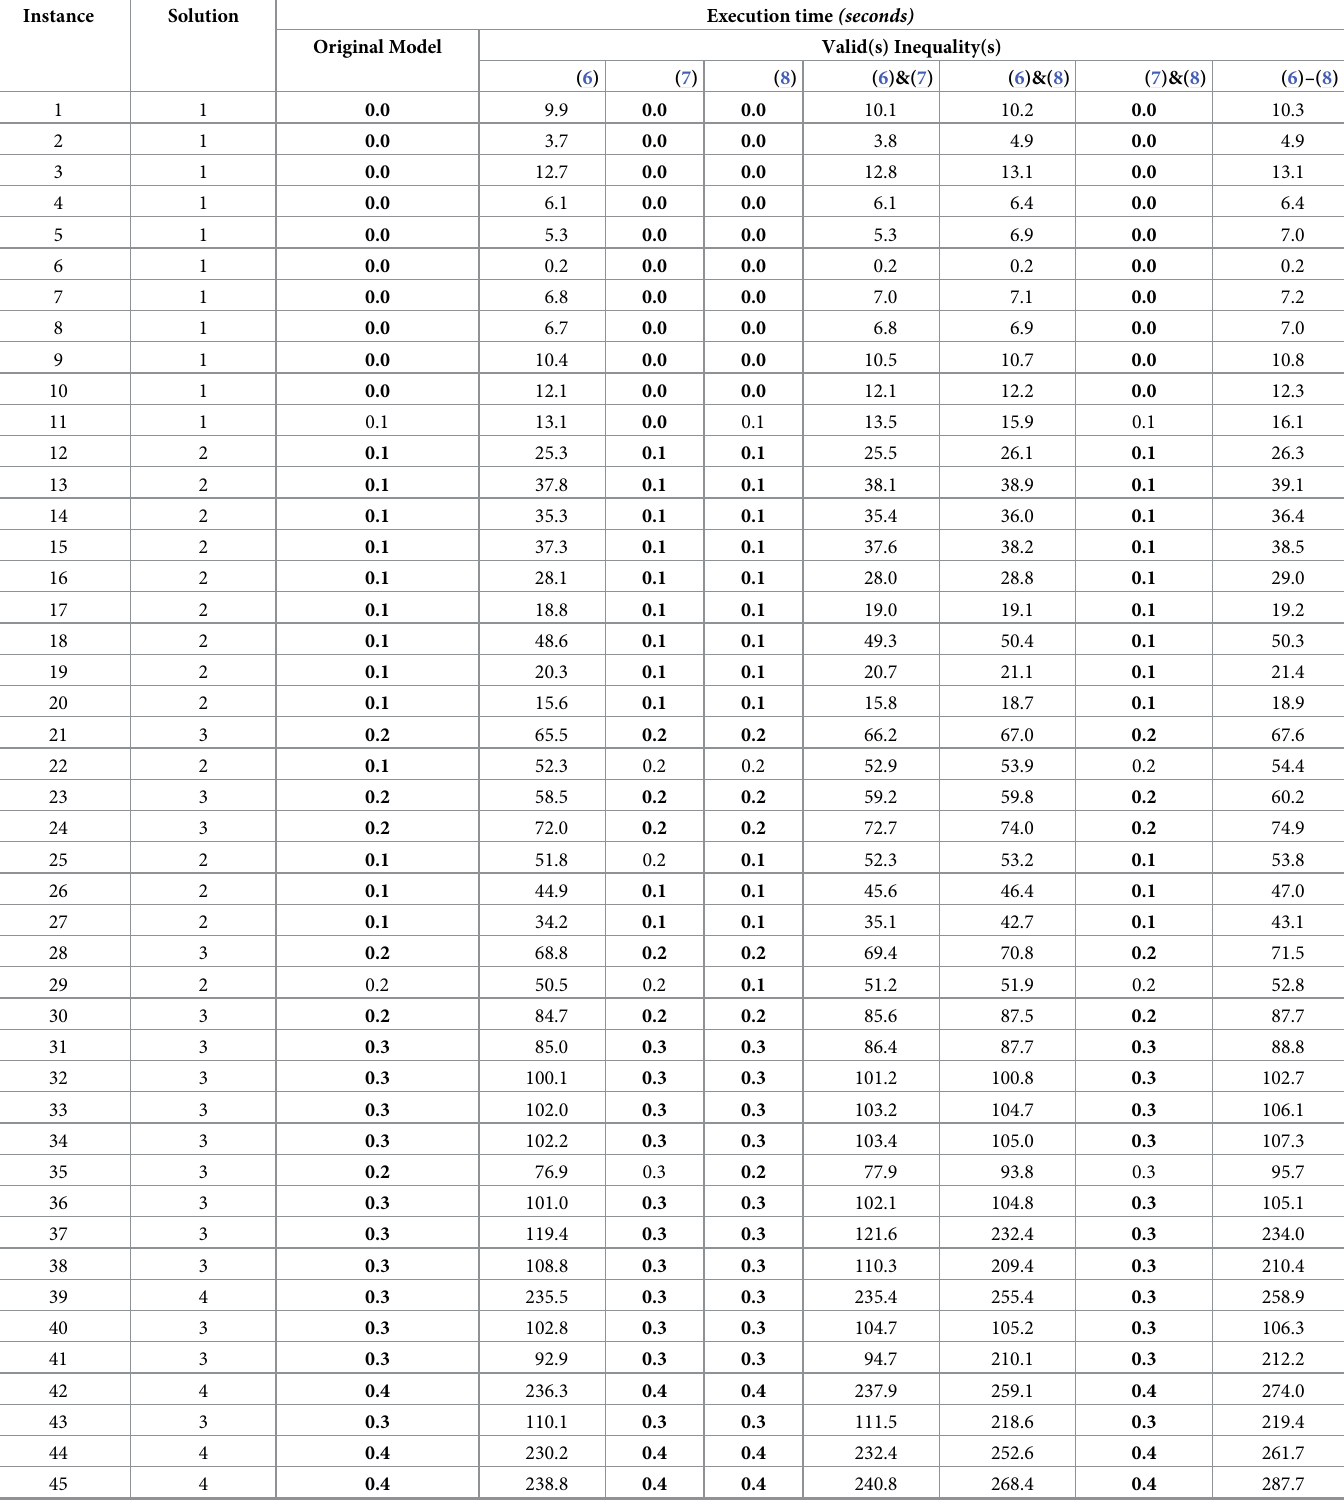
Table 6. Experimental results for Class 2 of the bwmv instances without rotations, applying the different families of valid inequalities to the set-covering ILP.